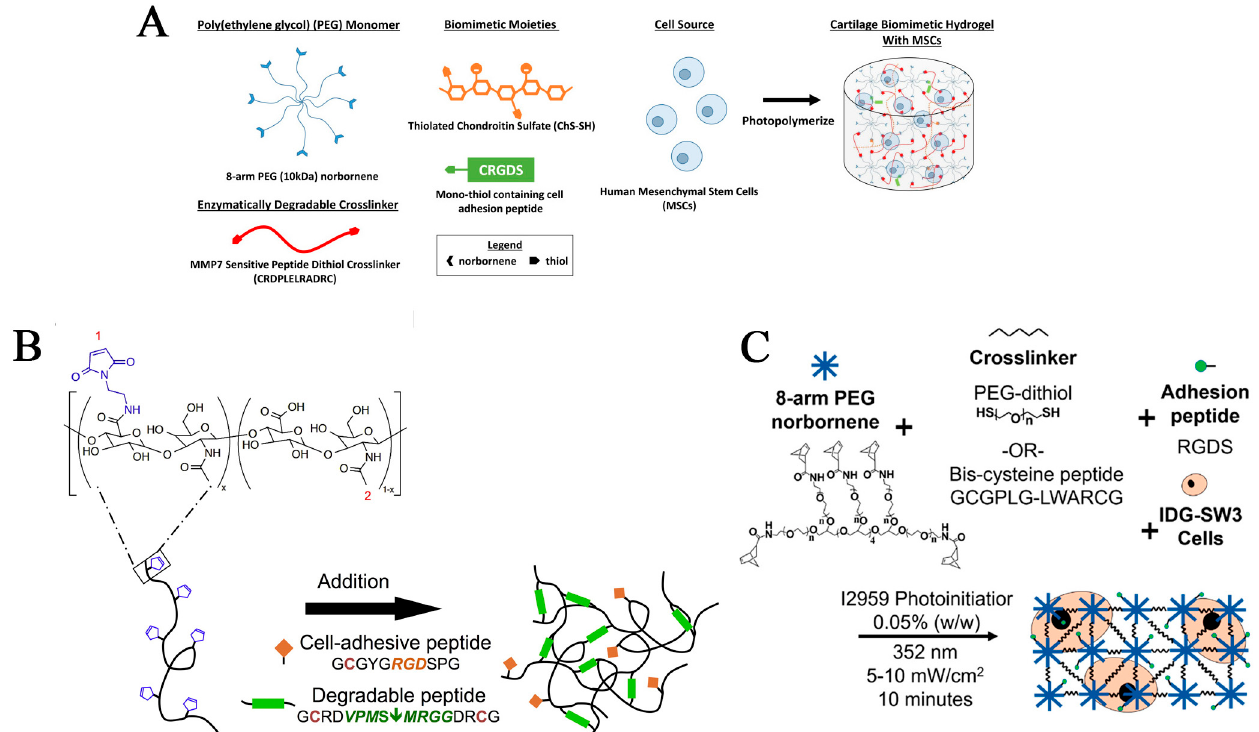
Figure 2. ( A ) Schematic illustration of the preparation of a human mesenchymal stem cell (hMSC)- encapsulated, MM7-responsive cartilage mimetic hydrogel. Reprinted with permission from [69]. ( B ) Maleimide-functionalized hyaluronic acid (MaHA) and the formation of cell-adhesive MaHA hydrogels. Cell-adhesive MaHA hydrogels were formed via an addition reaction between maleimides of MaHA and thiols of cysteine groups within cell-adhesive peptides (RGD) or MMP-sensitive degradable peptides (VPMS ↓ MRGG). Reprinted with permission from [66]. ( C ) Schematic of hydrogel formation and cell encapsulation through a photoclickable reaction. Reprinted with permission from